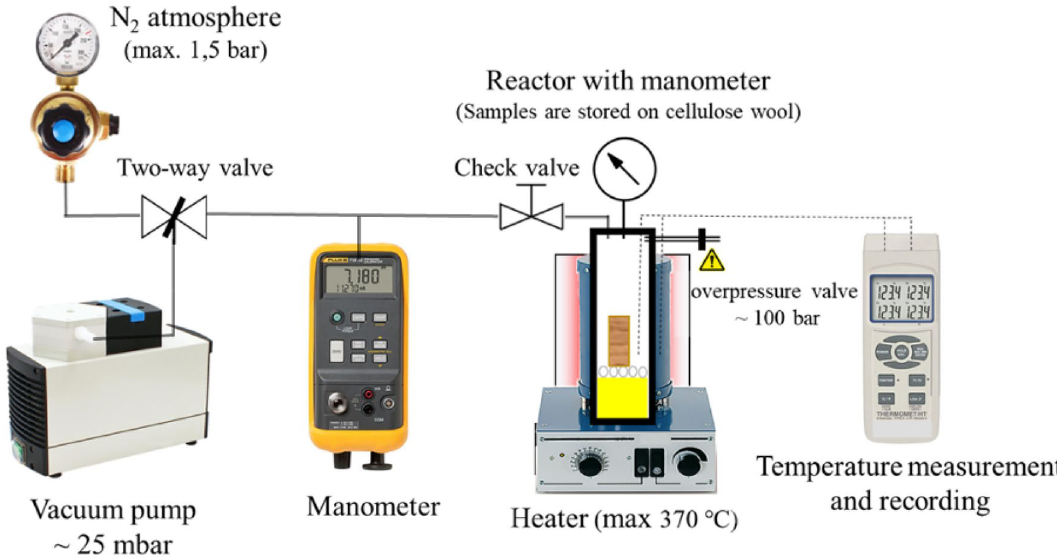
Figure 2. Thermal treatment in an inert